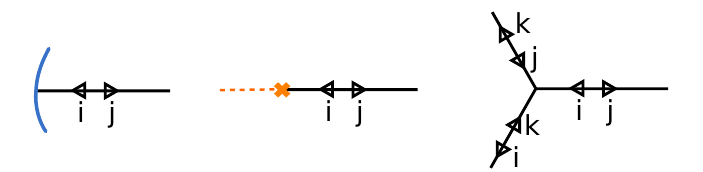
Figure 11 . The direct lift of a segment of L to sheet i of the covering f M .